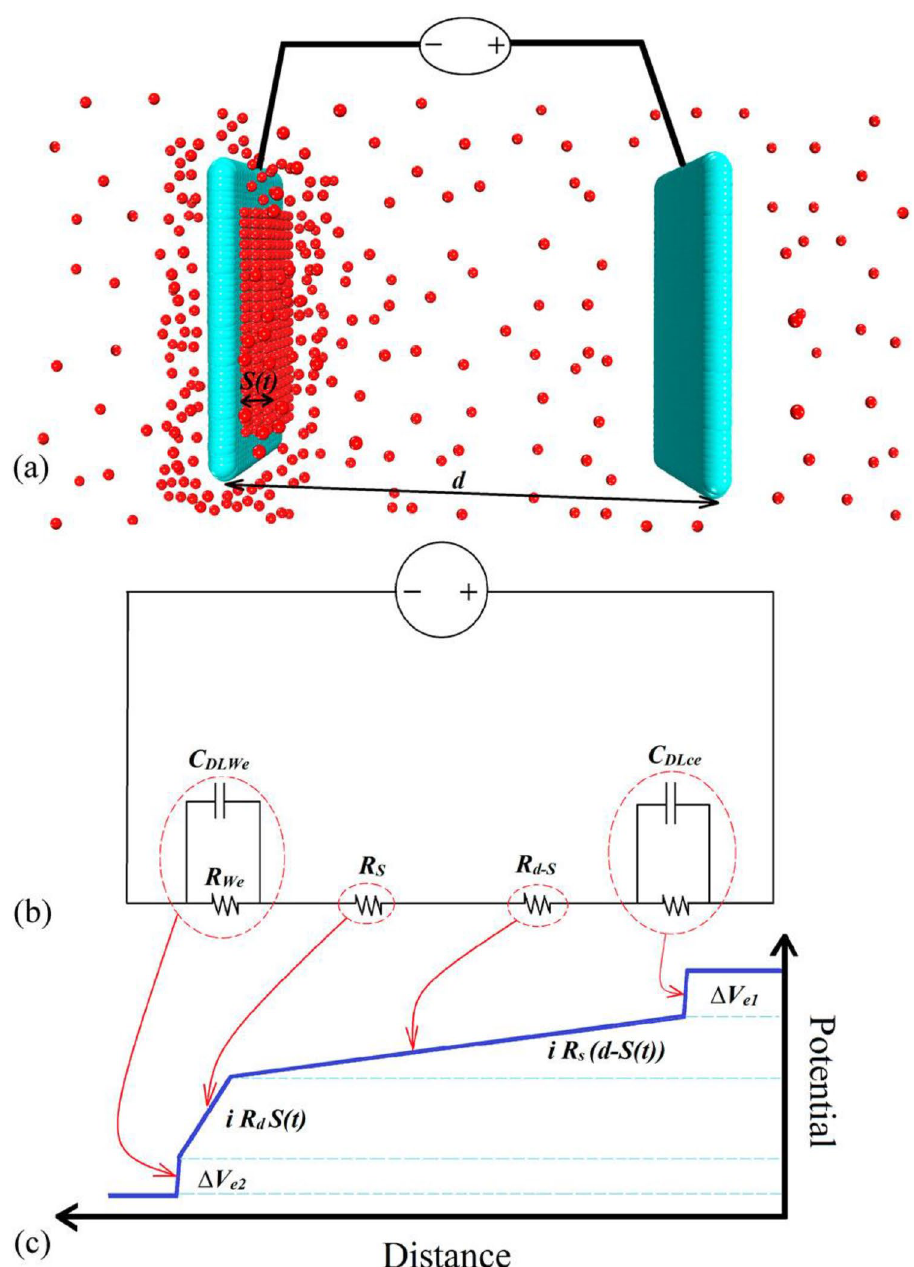
Fig. 1 A schematic view of the EPD cell, including a a thick deposit on the working elec- trode (WE) and a thin one on the counter electrode (CE), b a basic model of an EPD cell, and c variations of the potential of an EPD cell during deposition